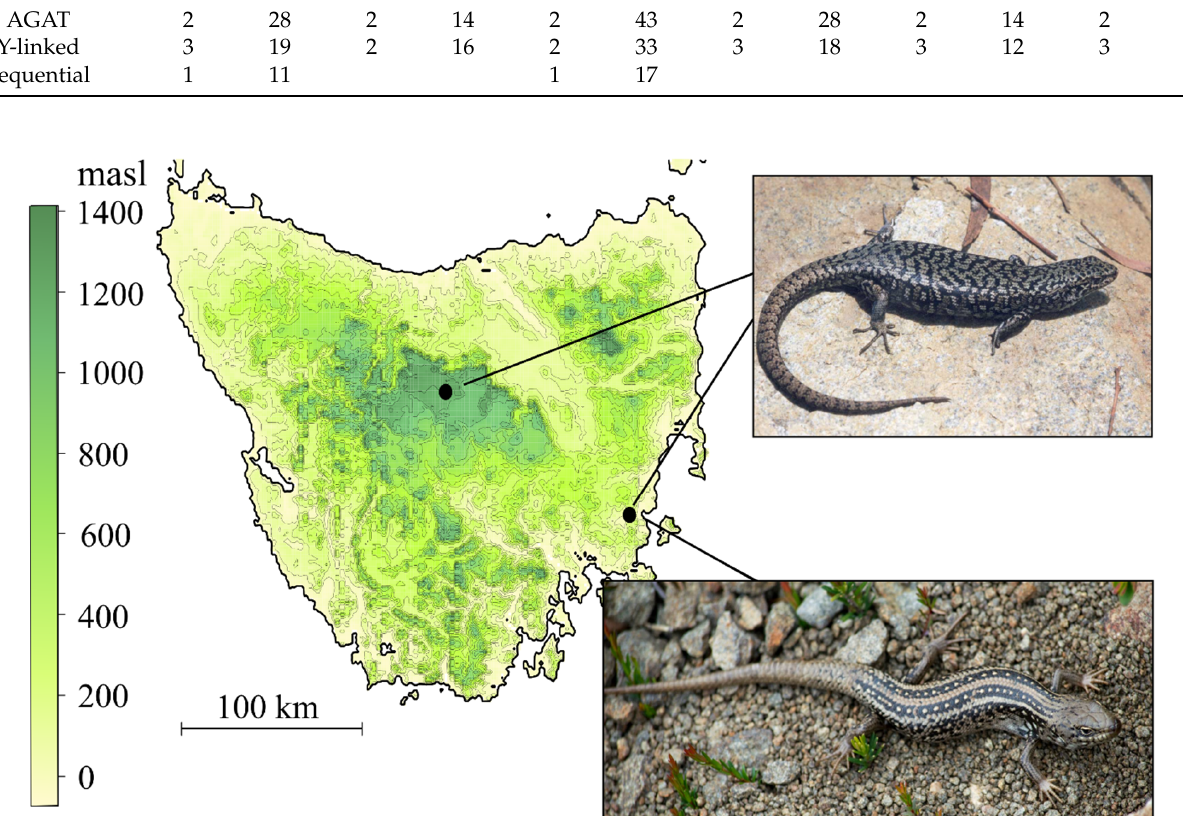
Figure 2. Sampling locations of Carinascincus ocellatus (inset, upper) and Liopholis whitii (inset, lower). C. ocellatus were sampled from high and low elevation populations exhibiting GSD and GSD+EE, respectively. Table 1. Number of male and female individuals and cells examined from whole blood culture of GSD (high elevation) and GSD+EE (low elevation) populations of Carinascincus ocellatus and a sin- gle population of Liopholis whitii . ‘Sequential’ FISH represents Y-linked and microsatellite FISH in series.